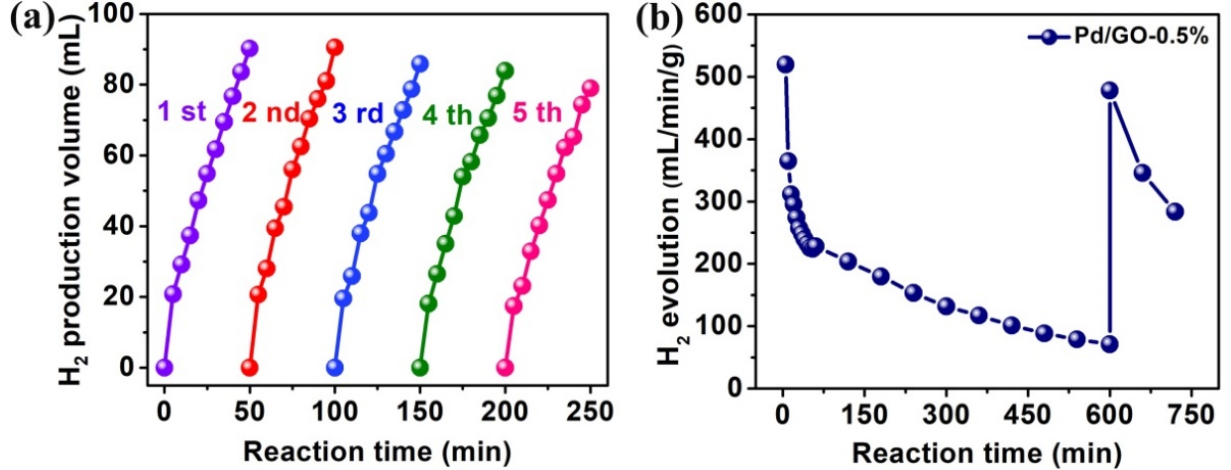
Figure 4. ( a ) Reusability and ( b ) long-term stability of H 2 revolution over Pd/rGO-0.5% catalyst. Reaction condition: T = 25 °C; HCHO: 0.6 M; NaOH: 1 M; and catalysts: Pd/GO-0.5%, 8 mg.